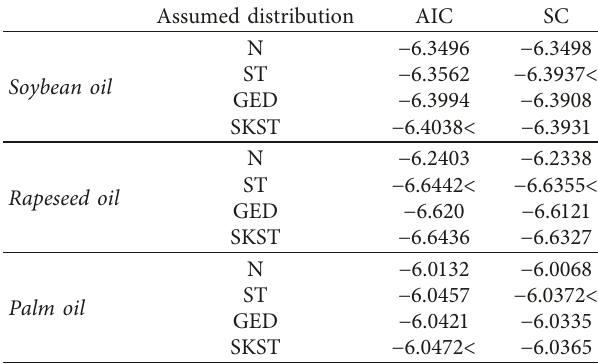
Table 3: EGAS (1,1) model AIC and SC estimation results.